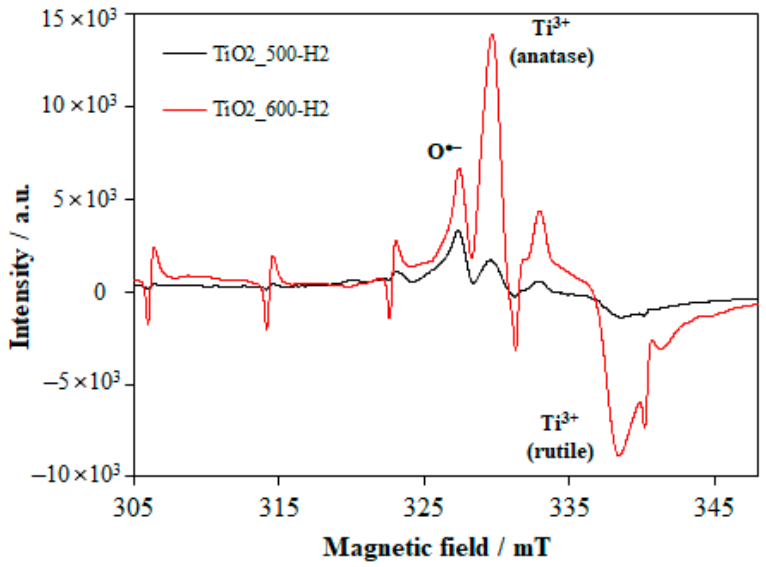
Figure 2. EPR spectra of TiO 2 samples heat treated at 500 and 600 ◦ C in H 2 .